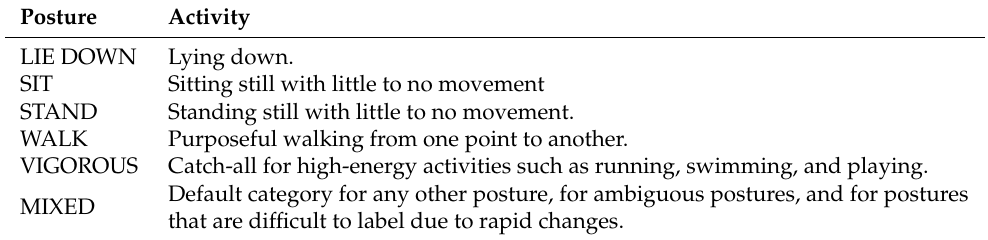
Table 2. Postures Ethogram.